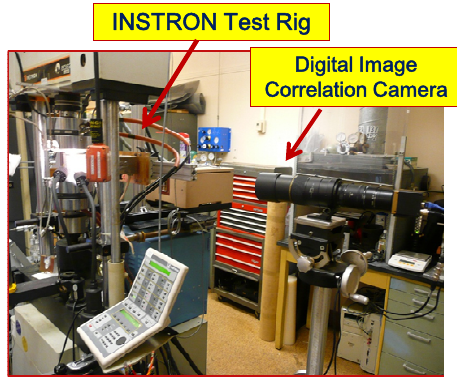
Figure 1. Camera configuration and tensile rig.